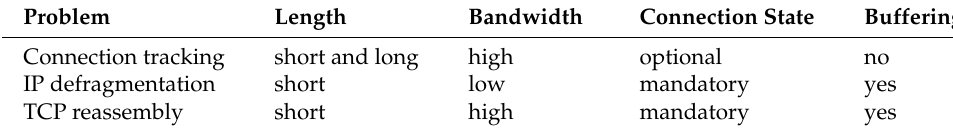
Table 1. Comparison between IP defragmentation and transport layer connection tracking.